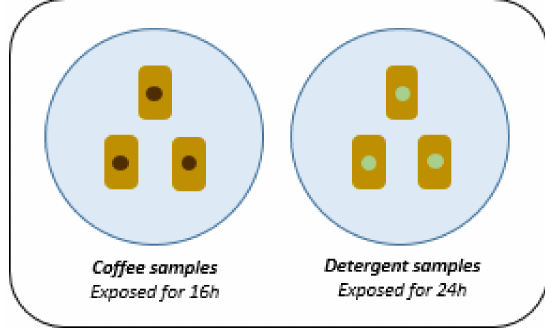
Figure 3. Chemical resistance test.